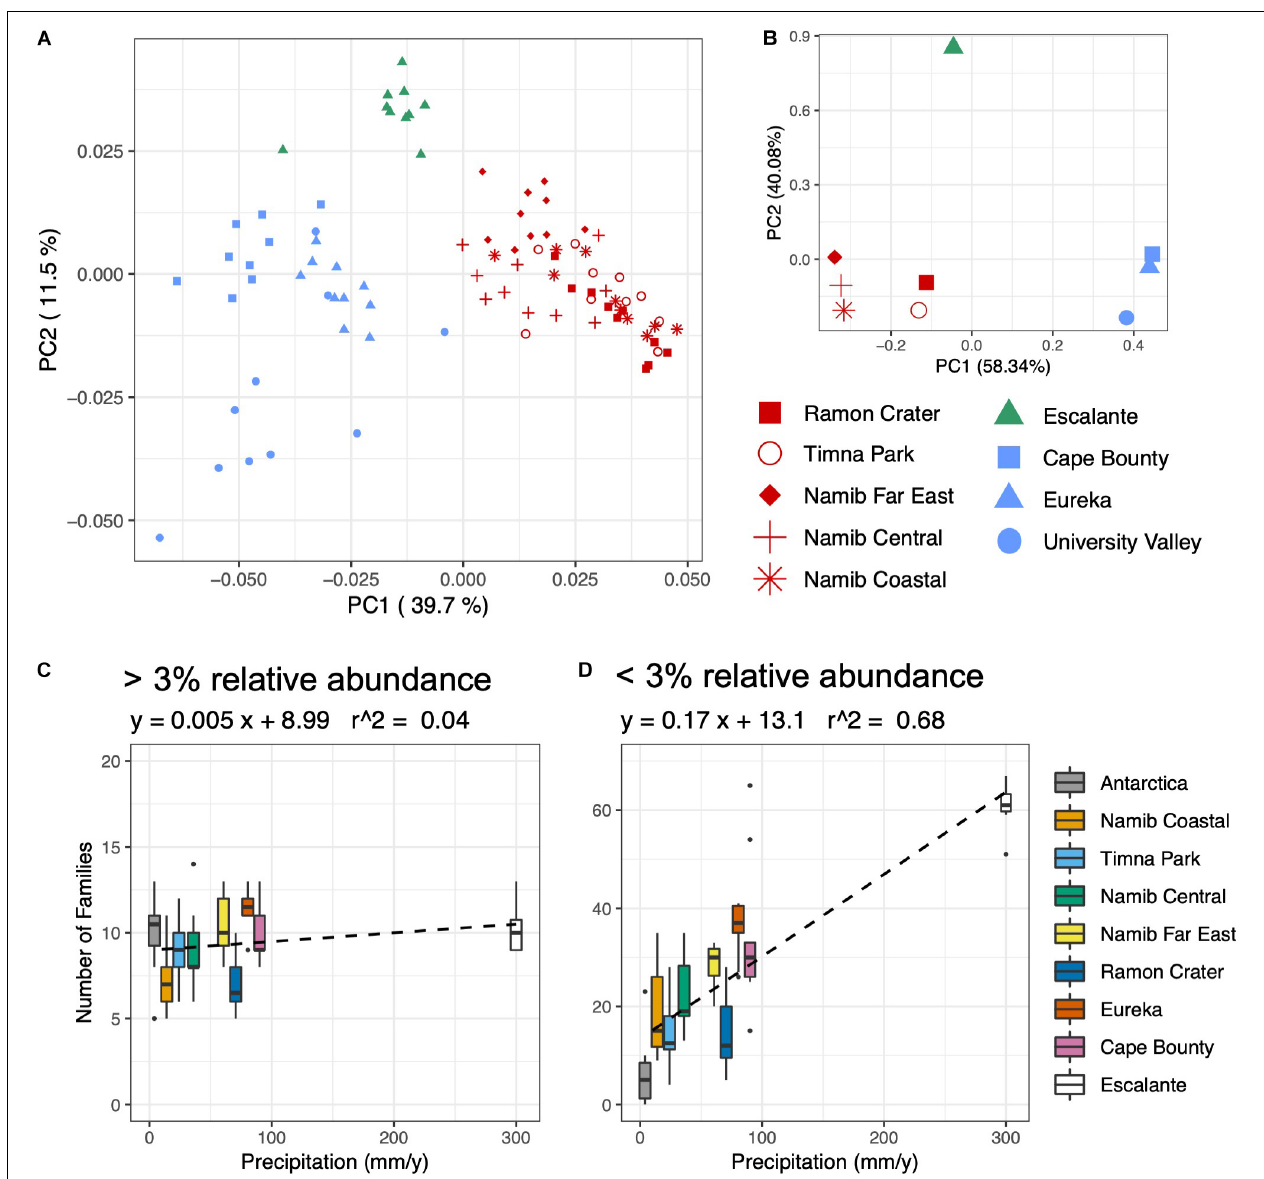
FIGURE 4 | Environmental correlations with bacterial community composition and diversity. (A) Principal coordinates analysis (PCoA) plot of weighted UniFrac distance of the prokaryotic community, based on 16S rRNA gene sequences rarefied to 1500 reads. Sites are colored according to climate regime, with red = hot/dry, blue = polar, and green = temperate. (B) PCA of Euclidean distance of climate variables: average temperature, precipitation, relative humidity, daily solar radiation. (C,D) Boxplots of number of families plotted against yearly precipitation for (C) families comprising over 3% of reads and (D) families comprising below 3% of reads.